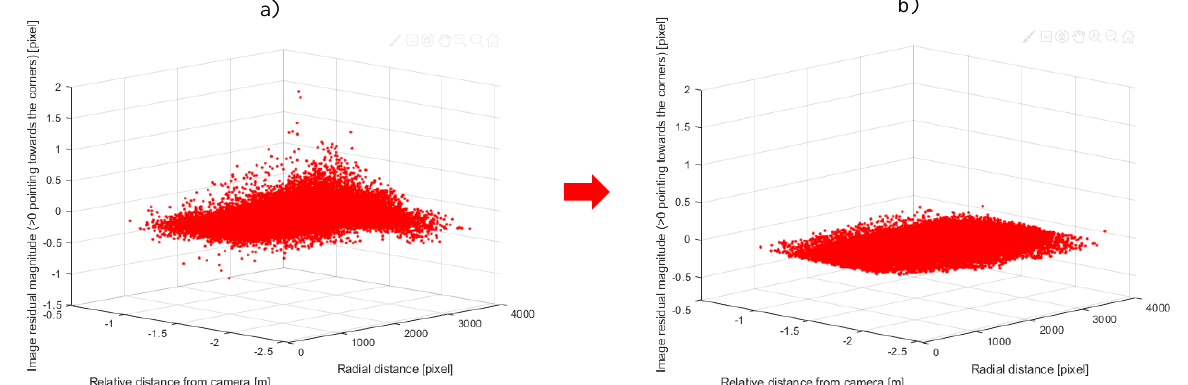
Figure 3 . Image residual plots as function of radial position on the sensor and point-to-camera relative distance before (a) and after (b) the polinomial